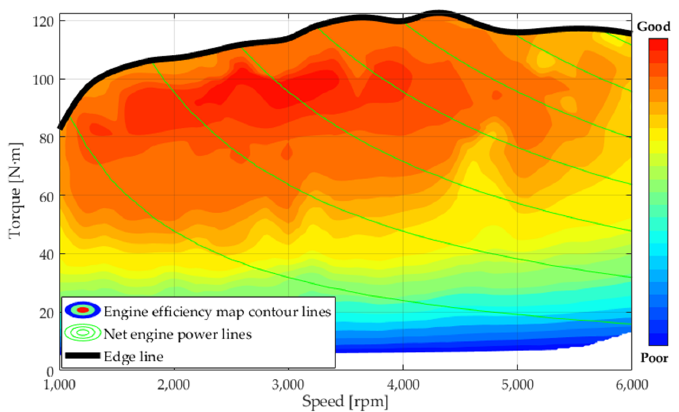
Figure 5. Engine efficiency map.